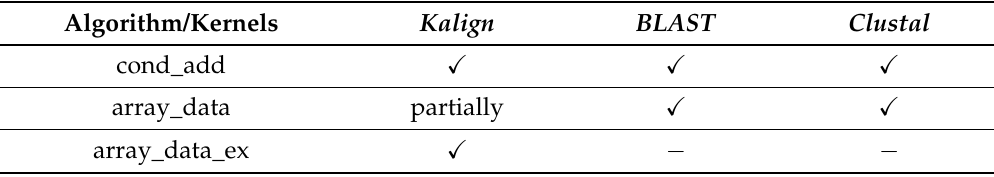
Table 1. Participation of the kernel in every algorithm. Algorithm/Kernels